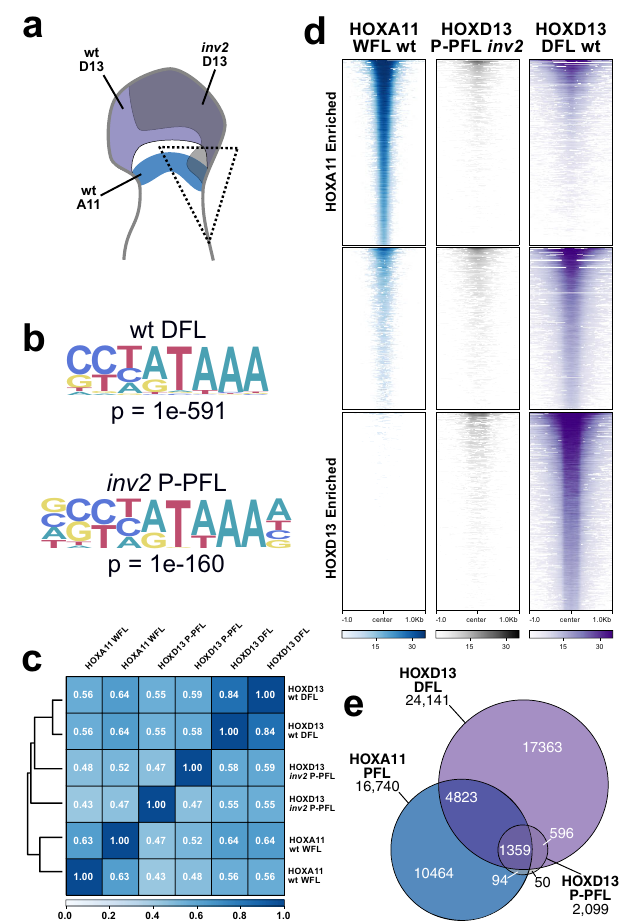
Fig. 4 Ectopic HOXD13 binds only to positions bound by HOXD13 in the distal limb. a Scheme as in Fig. 3, illustrating the dissection for this dataset. b HOXD13 consensus-binding motif found in E12.5 wild type distal forelimbs (DFL) and inv2 posterior proximal forelimbs (P-PFL) demonstrates that the protein binds to the same sequences in the ectopic domain as it does in the normal distal limb domain, although in the inv2 samples the motif was extended by one nucleotide on both sides. c Pearson correlation clustering on coverage from all replicates used for binding analysis demonstrating that the inv2 P-PFL HOXD13 coverage most closely clusters with the wild type DFL HOXD13 dataset rather than the coverage of HOXA11 in proximal limbs. d Heatmaps of genomic regions differentially bound by HOXA11 (ref. 51 ) at E11.5 in whole-forelimb samples (WFL) and HOXD13 at E12.5 in the distal forelimb of wild type embryos. Many of sites preferentially bound by HOXA11 are also bound by HOXD13 in the distal limb, but HOXD13 can also bind to many sites that HOXA11 does not bind to, as previously reported. The HOXD13-binding regions identi fi ed in the P-PFL tissue of inv2 limbs were mapped onto these differentially bound regions. HOXD13 in the P-PFL binds to a portion of sites bound in the wild type distal limb. e Euler diagram of binding sites identi fi ed as signi fi cant peaks in both replicates of each experiment. The majority of HOX13-binding sites in the P-PFL overlap with HOXA11 sites. All samples are homozygous for the indicated